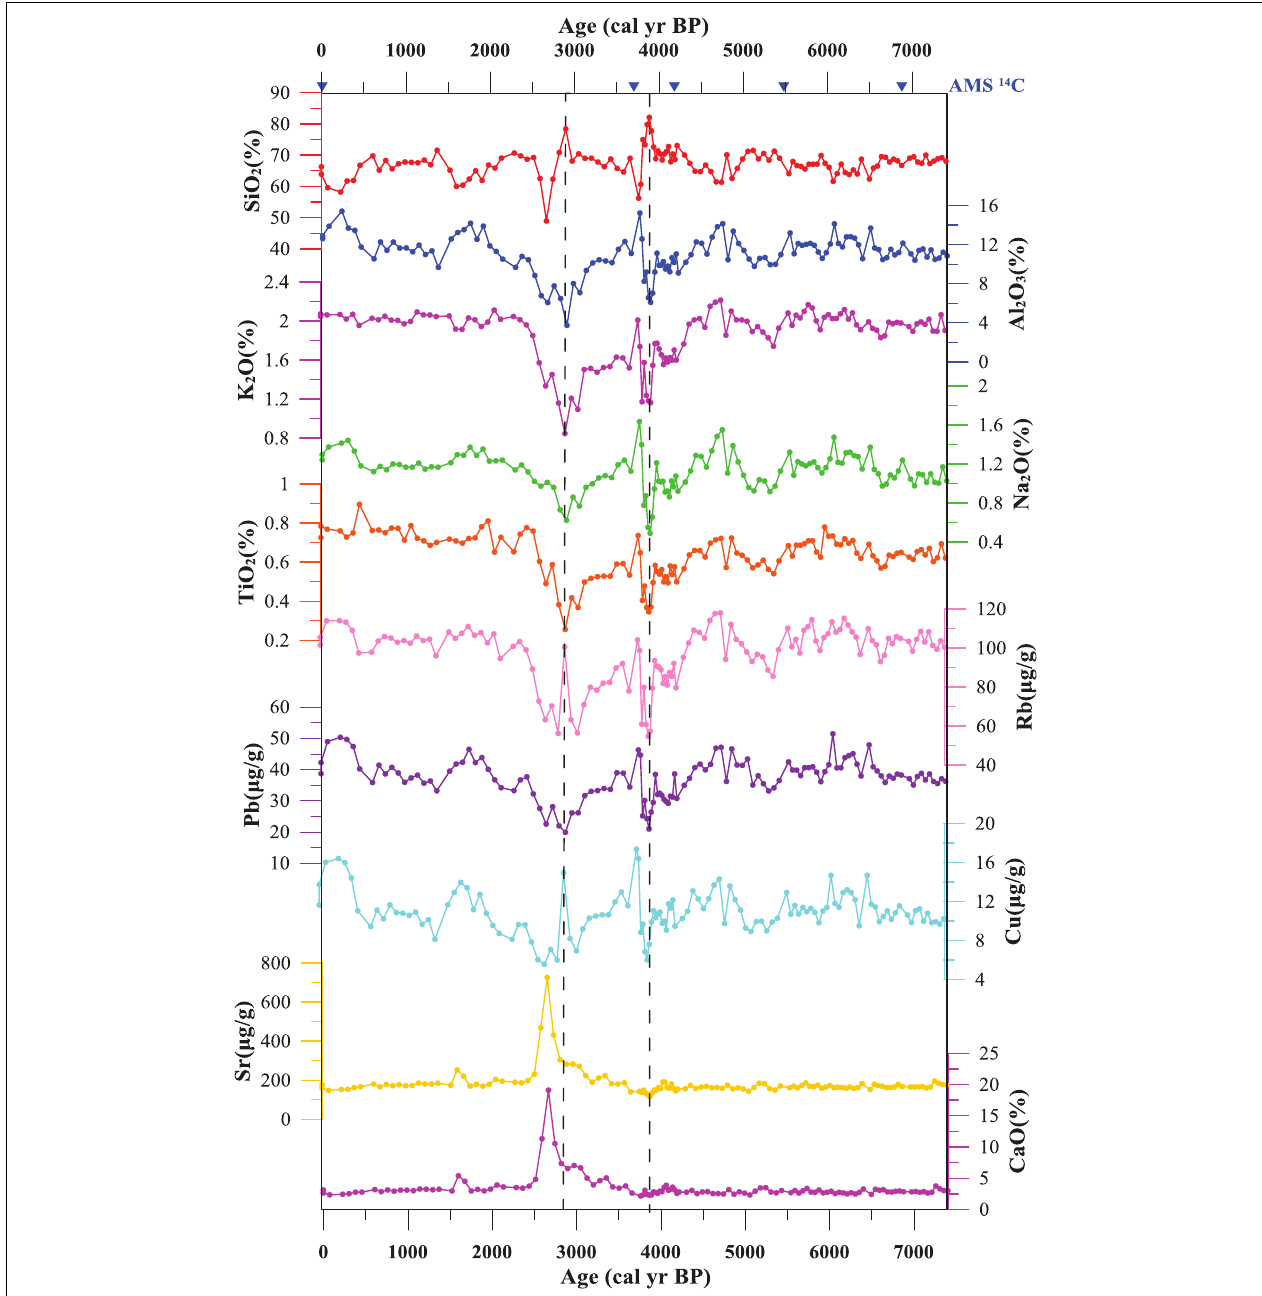
FIGURE 5 | Variations in major and trace elements of Core